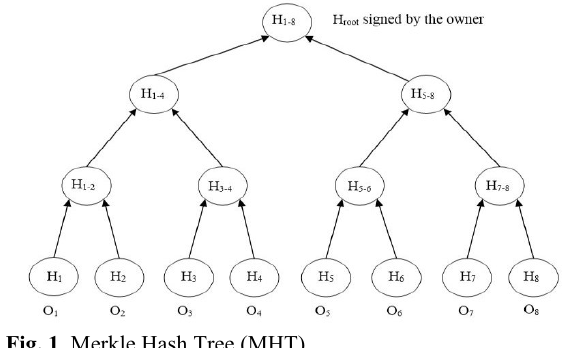
Fig. 1 . Merkle Hash Tree